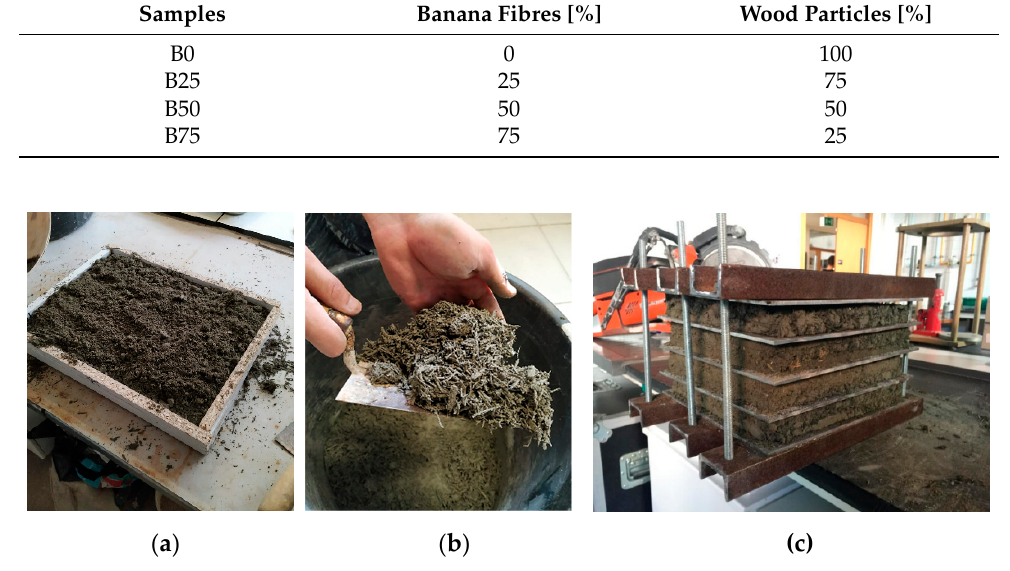
Figure 2. CBPB manufacturing: ( a ) homogeneous material obtained after 3 min of blending; ( b ) material placed into the molding; ( c ) layers of material before being pressed at 24 MPa.